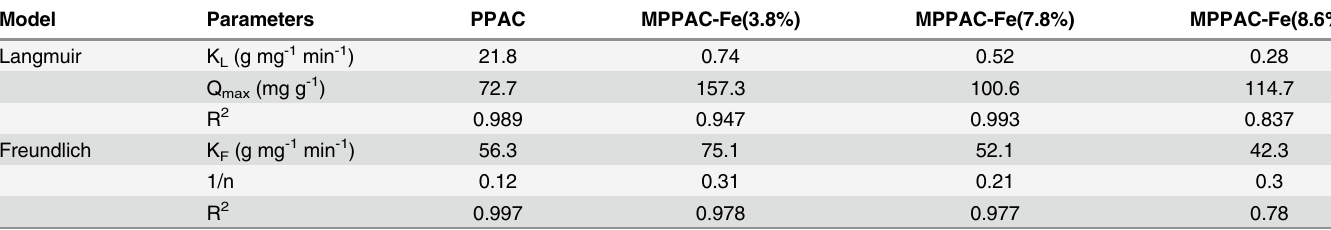
Table 2. Fitting parameters to the Freundlich and Langmuir models.